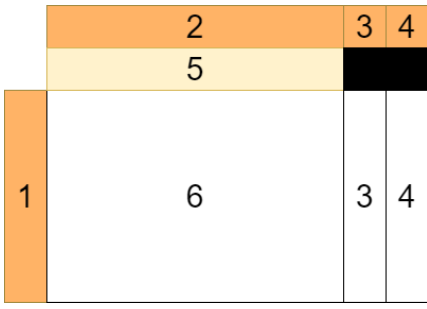
Figure 12. Concept figure of Lean DfX weighting table.